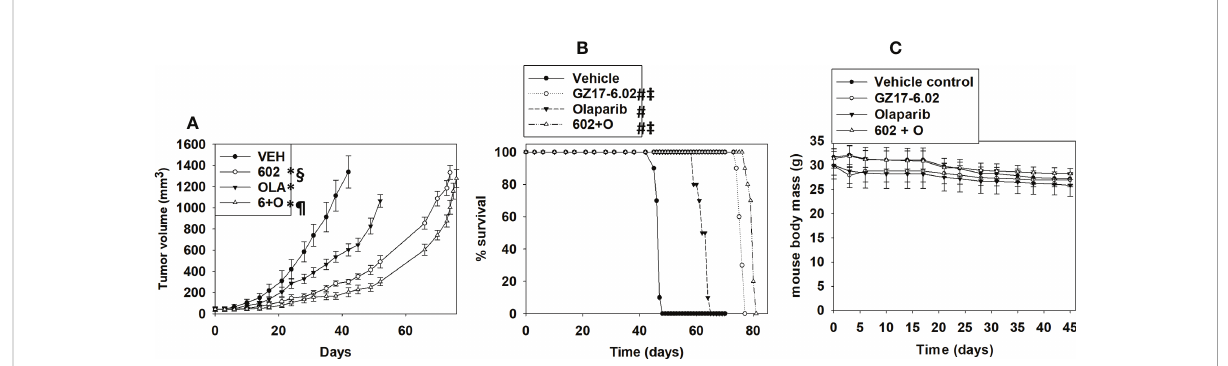
FIGURE 15 GZ17-6.02 profoundly suppresses the growth of AR+ prostate cancer tumors, prolonging survival, and interacts with olaparib to further reduce tumor growth. Male NRG mice supplied by the Massey Cancer Center Animal Core ( ∼ 20 g) were injected with 1.0×10 6 male LNCaP cells into their rear fl ank (10 animals per treatment group). Tumors were permitted to form for 1 week with tumors at that time exhibiting a mean volume of approximately 50 mm 3 . Mice were treated by oral gavage once every day for 45 days with vehicle control, GZ17 ‐ 6.02 (50 mg/kg), olaparib (10 mg/kg) or the drugs in combination. Before, during and after drug treatment tumors were calipered every ~3 days as indicated in (A) and tumor volume was assessed up to 45 days later. Tumor volumes under each condition are plotted. * p < 0.05 reduced growth compared to vehicle control; § p < 0.05 reduced growth compared to olaparib single agent; p < 0.05 reduced growth compared to GZ17-6.02 single agent. Animals were humanely killed when the tumor volume reached approximately 2,000 mm 3 due to ulceration. Animal survival was plotted on a Kaplan – Meier curve (B) . # p < 0.05 greater survival than vehicle control; ‡ p < 0.05 greater than olaparib single agent. In (C) the body mass of the mice in the study is presented over the 45-day treatment time